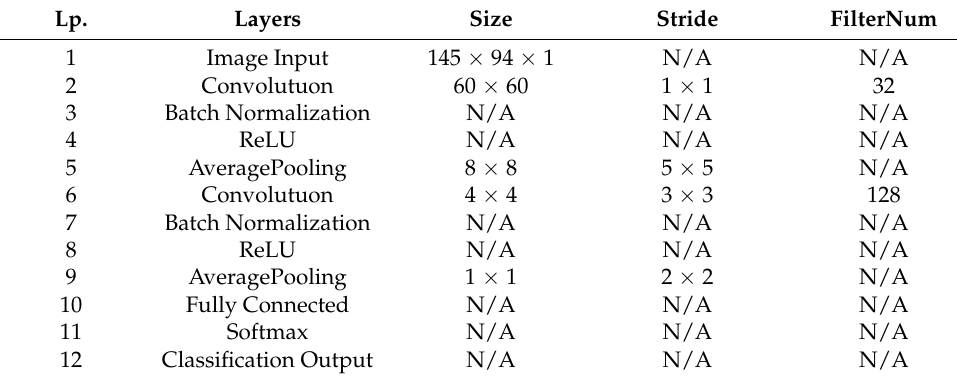
Table 5. Final DCNN structure and configuration of successive layers.